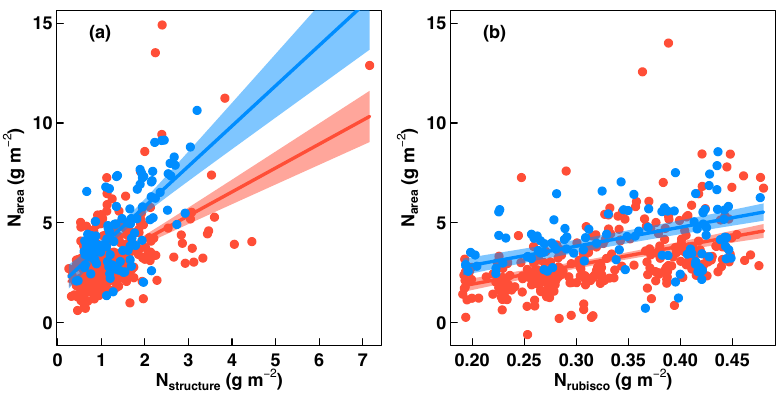
Figure 3. Partial residual plots for the linear regression of N area as a function of independently predicted values of N rubisco and N structure (all in gm − 2 ) at species level. Blue: N-fixers; red: non-N-fixers. Table 2. Linear regression coefficients for community-mean (simple average) values of ln N area (gm − 2 ) as a function of c i : c a (from δ 13 C),